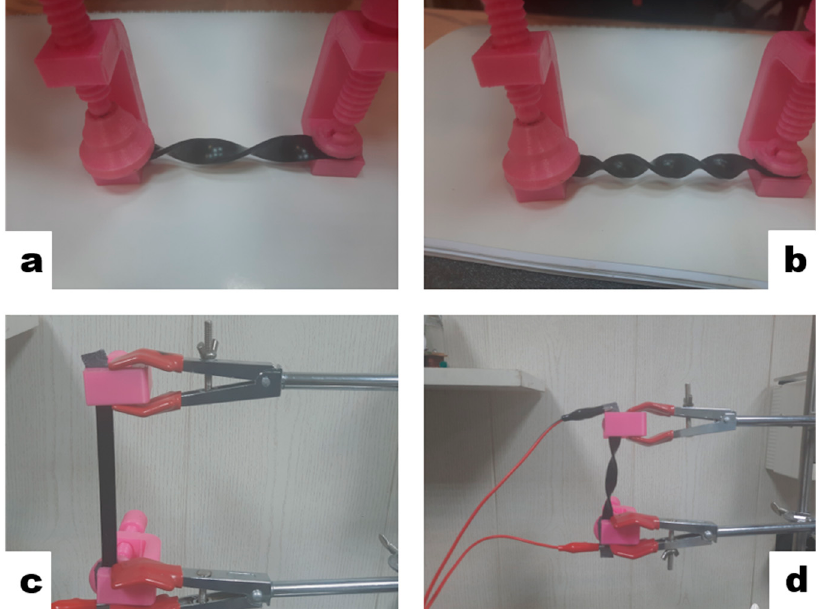
Figure 2. The samples under different tensions. ( a )—360° torsion, ( b )—720° torsion, ( c )—tension, and ( d )—360° torsion with connected electrodes.